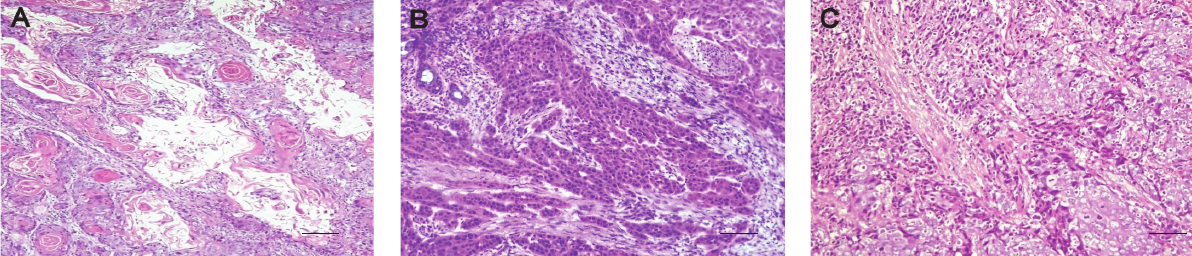
Figure 3: Photomicrograph of the NPC histological subtypes. (A) Type 1 NPC: differentiated malignant squamous cells showing keratin peals (keratin formation). (B) Type 2 NPC: the tumour cells are spindle shaped with elongated dark nuclei and tapering cytoplasm. (C) Showing a type 3 NPC. The tumour cells have vesicular nuclei and prominent nucleoli; the cytoplasm has indistinct cytoplasmic borders. The small basophilic cells depict lymphocytosis (H&E stain 100x). Bar = 20 𝜇